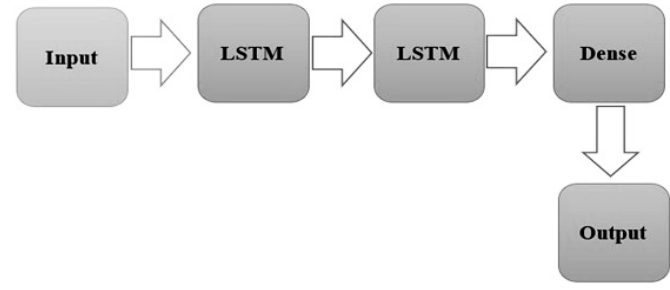
Figure 5. A stacked LSTM architecture.